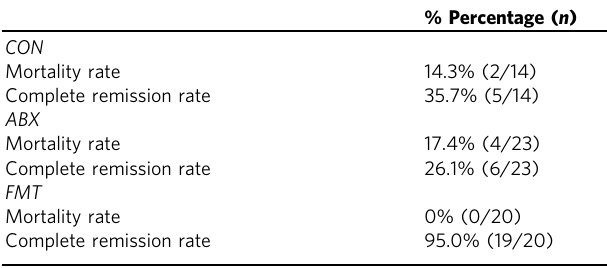
Table 2 The mortality rate (%) and the complete remission rate (%) of the diarrheic calves, according to